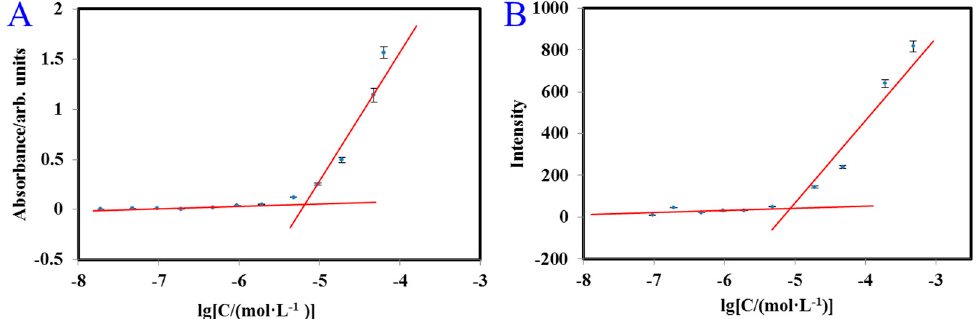
Figure 4. Determination of CMC of FA-2-DG by plotting of the UV absorbance at 280 nm ( A ) and fluorescence intensity at 442 nm ( B ) against the logarithm of the concentration.